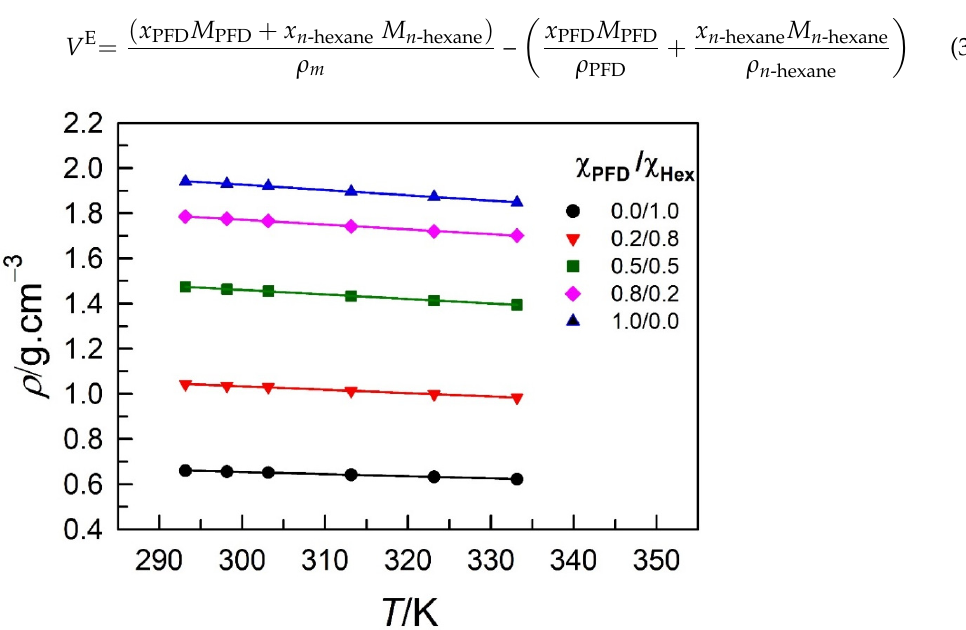
/(g ∙ cm − 3 ) + 𝑏 ( x ) + c ( x PFD2 ). Parameters 𝜌 o,x , 𝑏 , and 𝑐 , /(g · cm − 3 ) + b ( x PFD ) + c ( x PFD 2 ). Parameters ρ 0, x , PFD PFD PFD PFD PFD